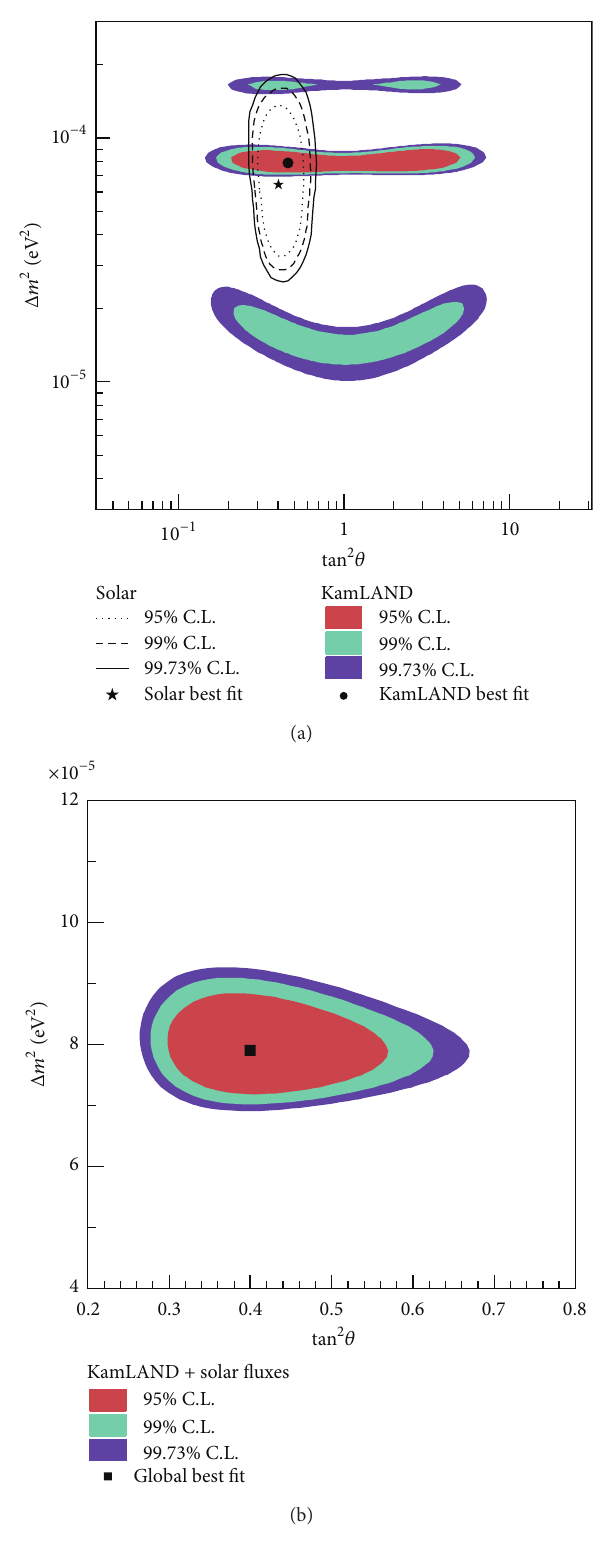
Figure 4: (a) Allowed region of the neutrino oscillation parameter from KamLAND antineutrino data (colored regions) and solar neutrino experiments (lines) [30]. (b) the result of a combined two- neutrino oscillation analysis of KamLAND and the observed solar neutrino fluxes under the assumption of CPT invariance. Taken from